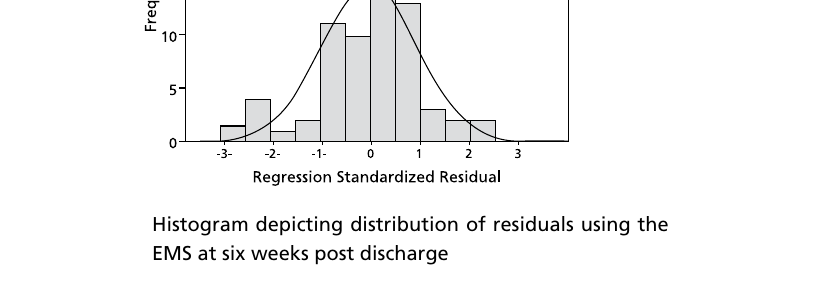
Histogram depicting distribution of residuals using the EMS at six weeks post discharge